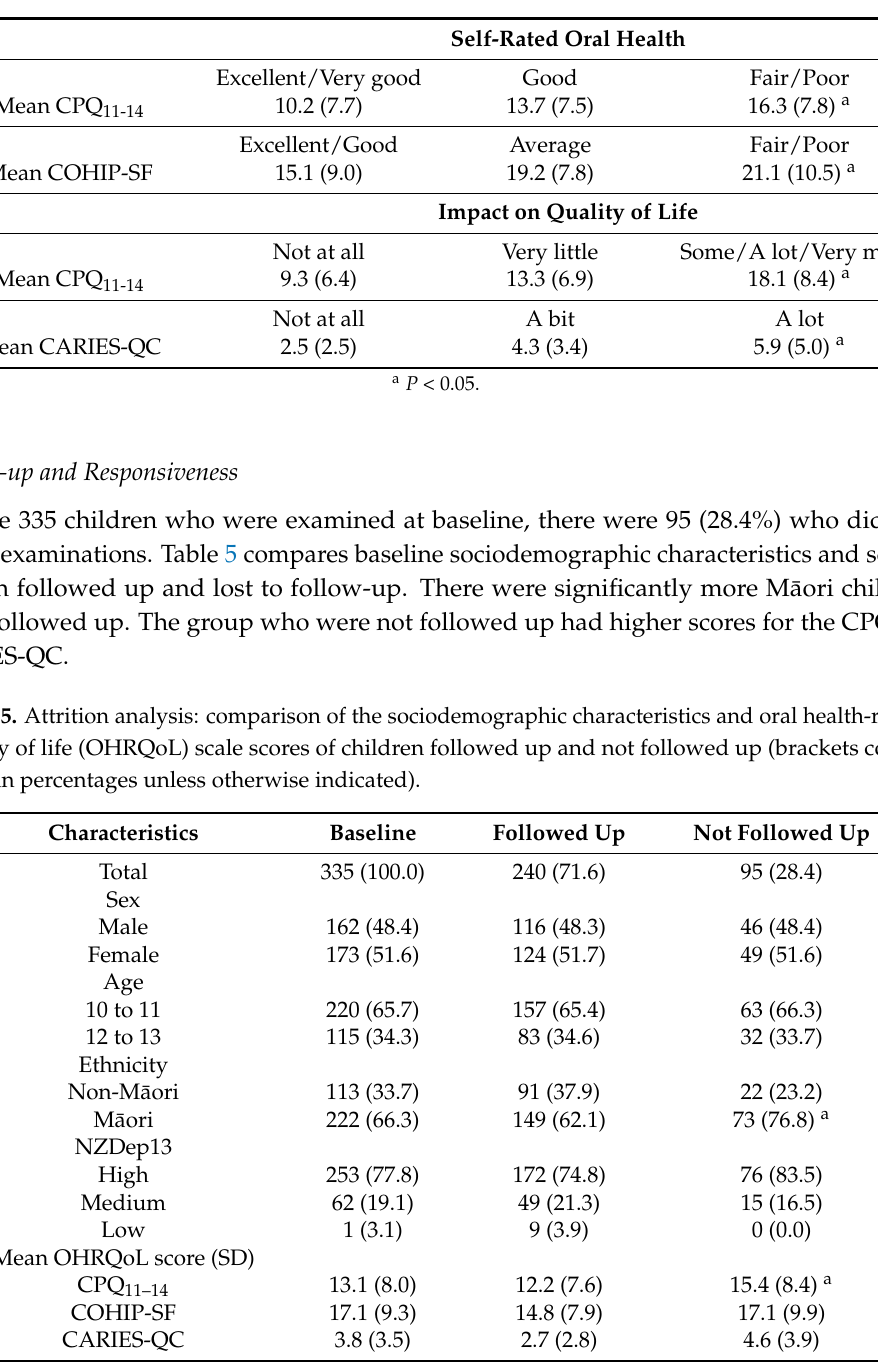
Table 4. Mean CPQ 11–14 , COHIP-SF and CARIES-QC scores by their global oral health questions (brackets contain standard deviations).